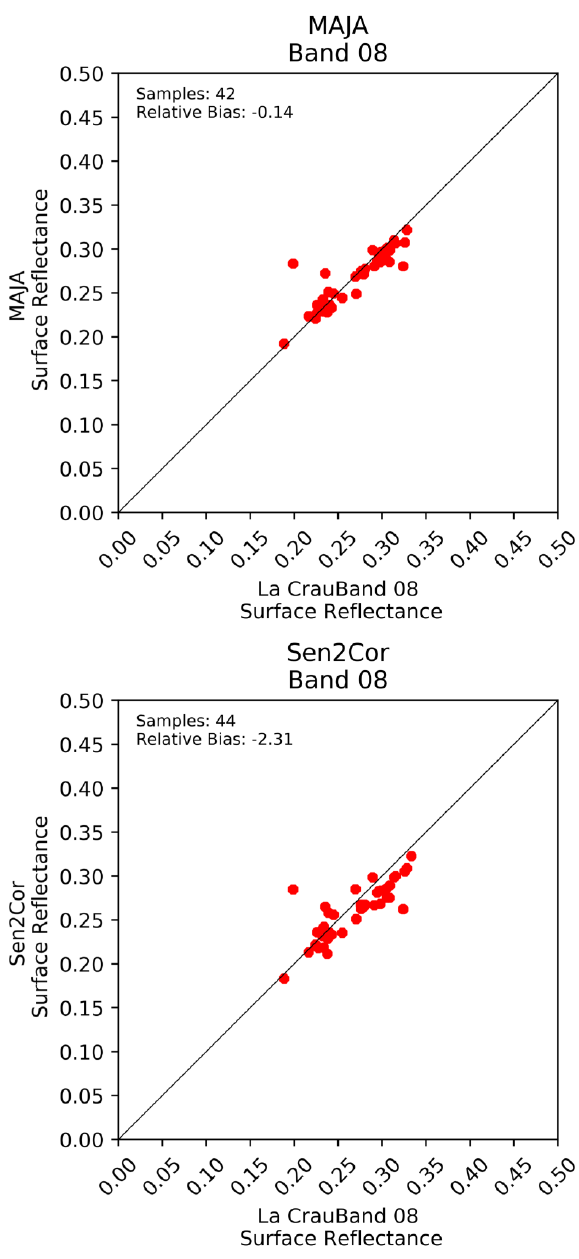
Figure 4. Surface reflectance validation over La Crau for Sentinel-2 band B4, results are provisional